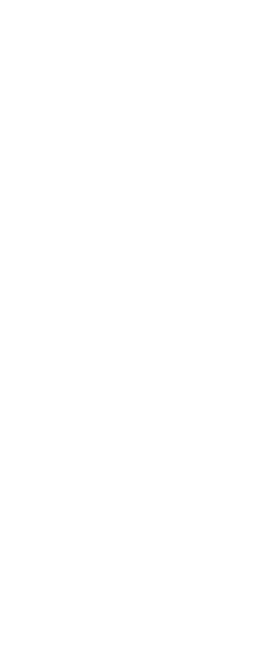
Table 4. Results on digital business